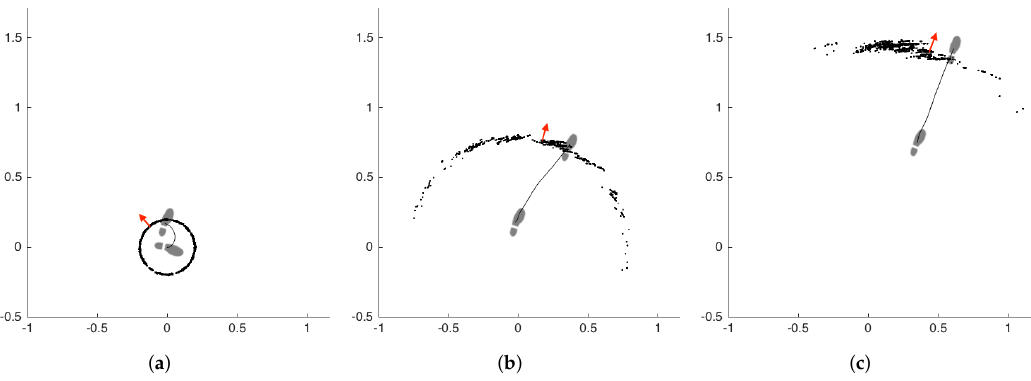
Figure 7. Example particle filter (PF) operation (footprints: true orientation; red arrows: estimation of